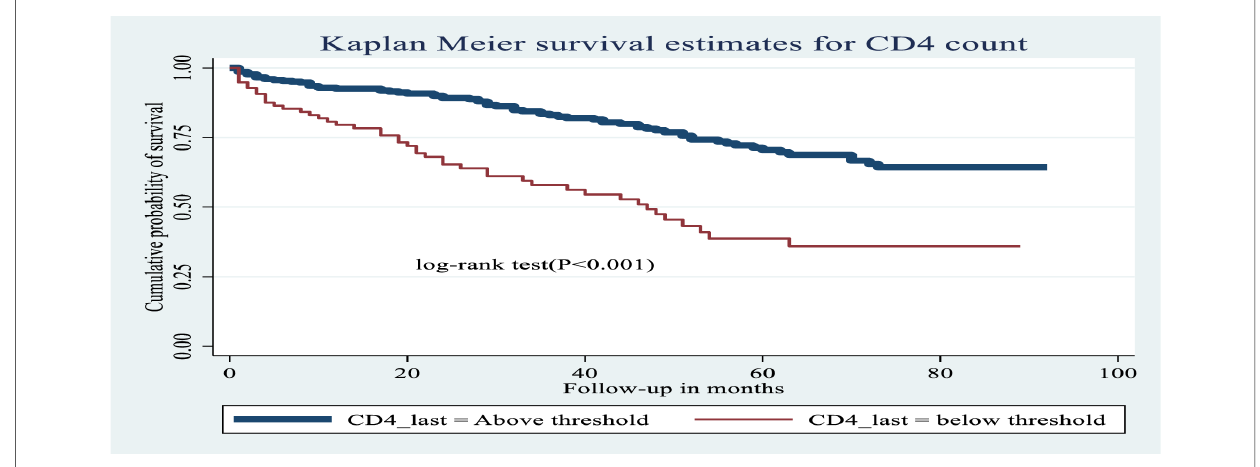
FIGURE 6 Kaplan – Meier estimates of probability of OI-free survival by CD4 cell count (above or below threshold) among HIV-infected children receiving ART at Amhara regional state comprehensive specialized hospitals, Ethiopia,